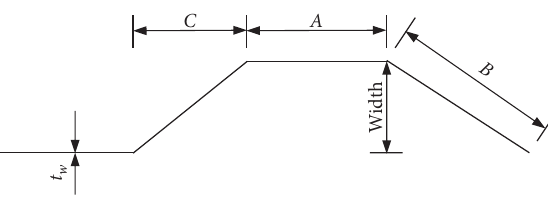
Figure 11: Dimensions of GFRP corrugated steel web. Table 5: Mode frequencies: FE model (straight webs) vs. FE model (corrugated webs).